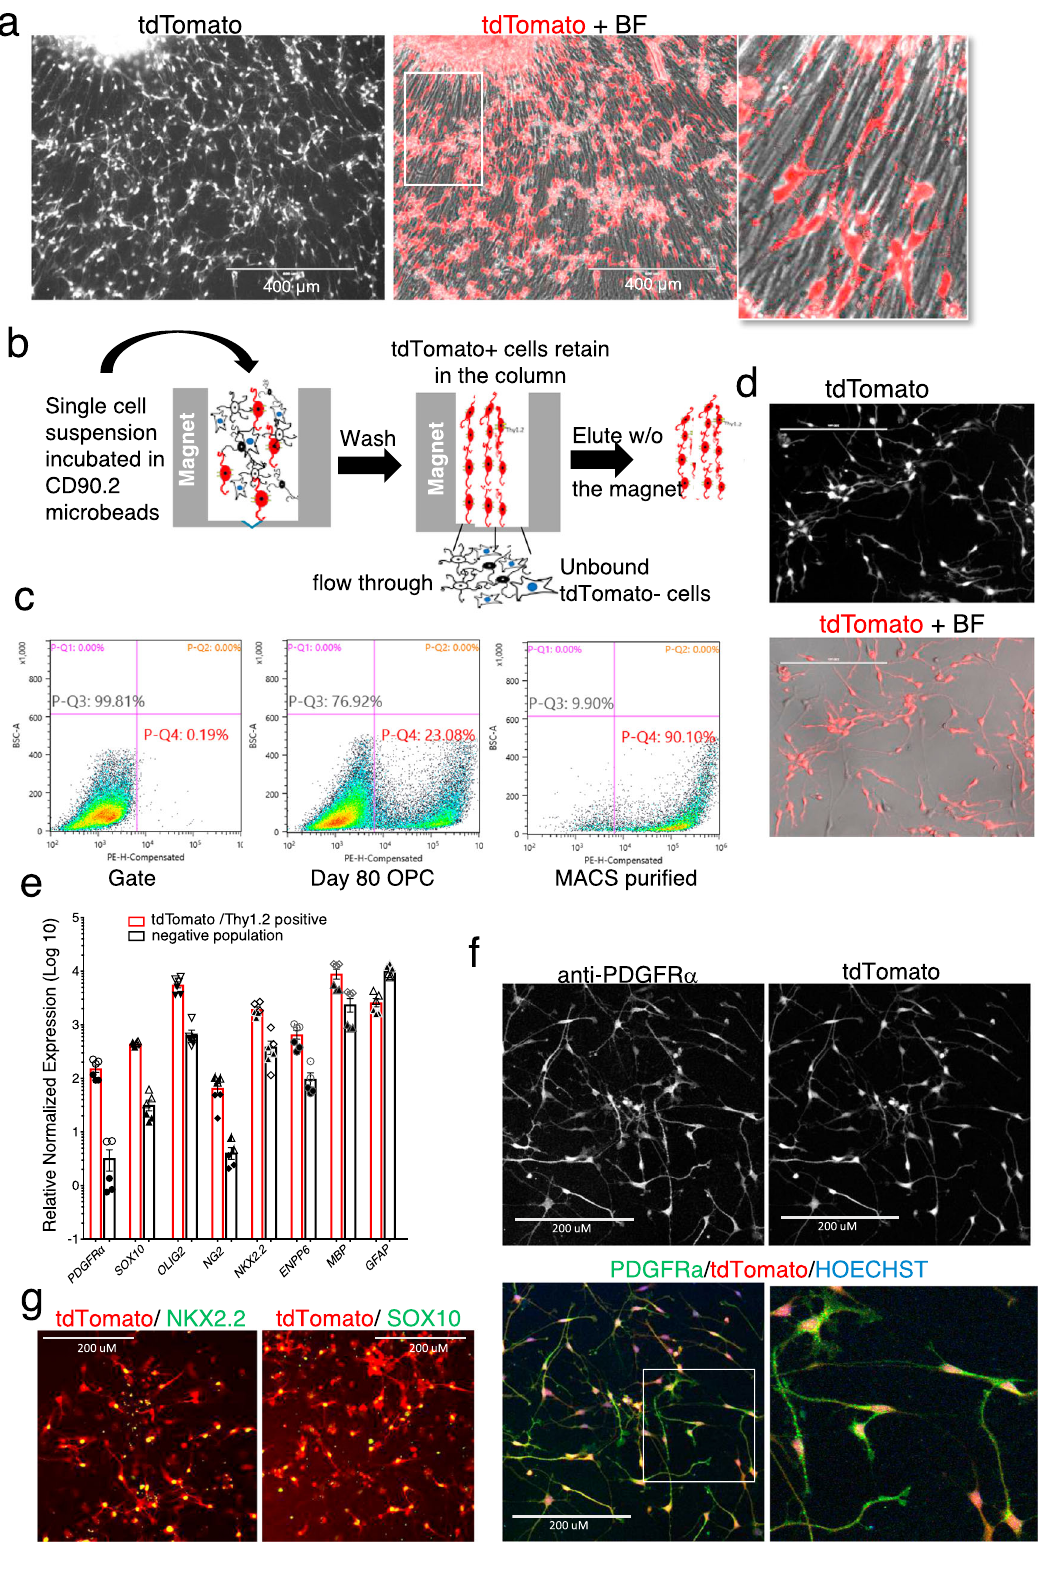
When puri fi ed tdTomato + cells were plated on either laminin- coated surface or plates containing electrospun nano fi bers for another 3 weeks, they continued to differentiate into mature OLs. The OL cultures were stained with an antibody against MBP and MBP + cells displayed the distinct, typical branched morphology